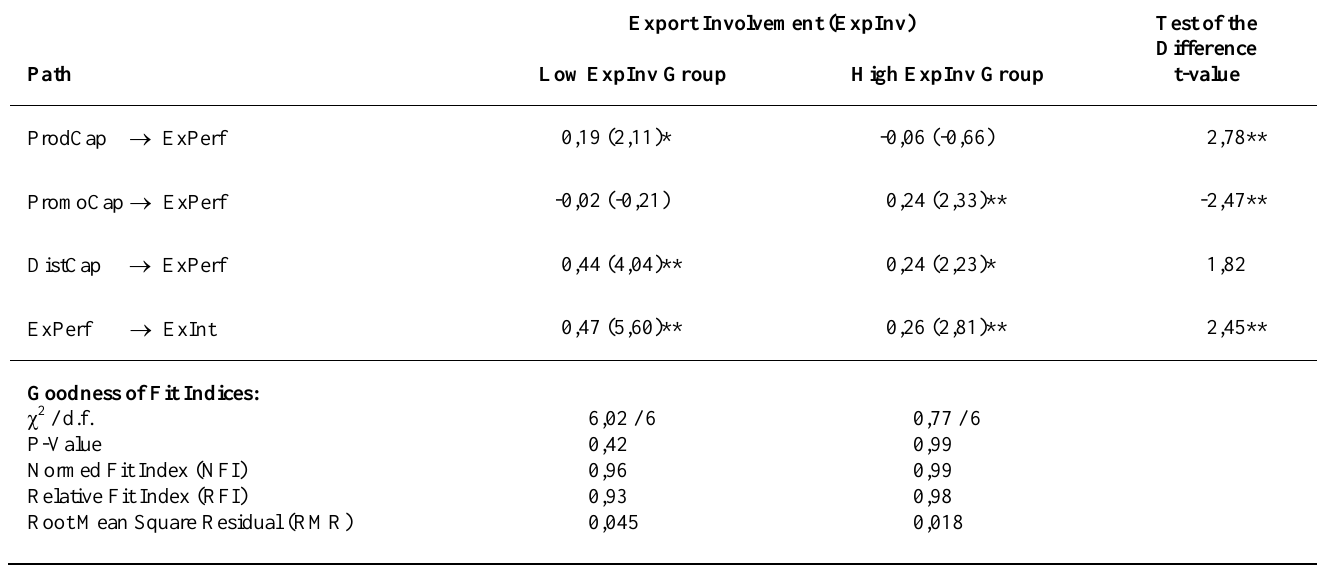
Table 2: Parameter estimates and t-values